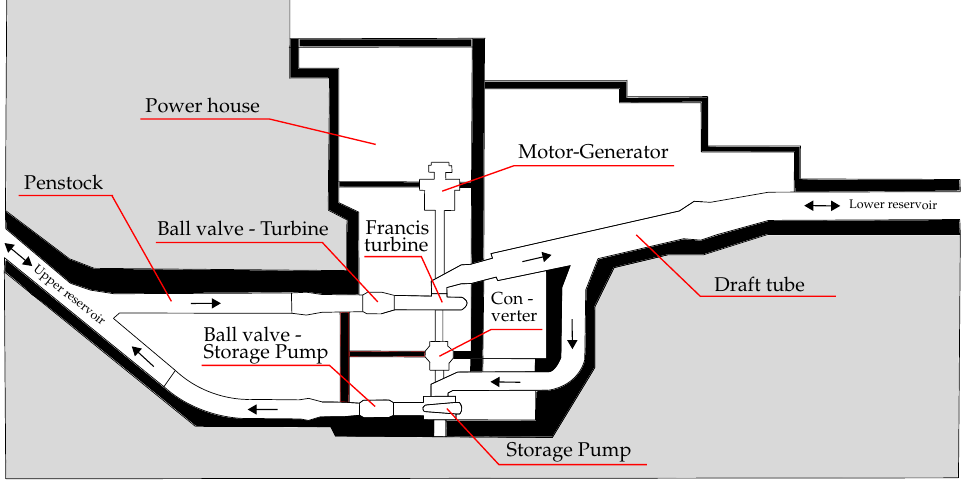
Figure 2. Sketch of the hydropower